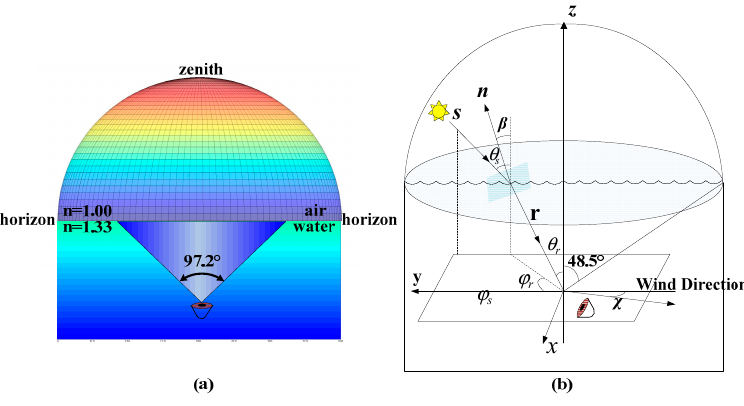
Figure 3. ( a ) Snell’s window for flat water; and ( b ) the coordinate sketch of the refracted process under the wavy water surface.